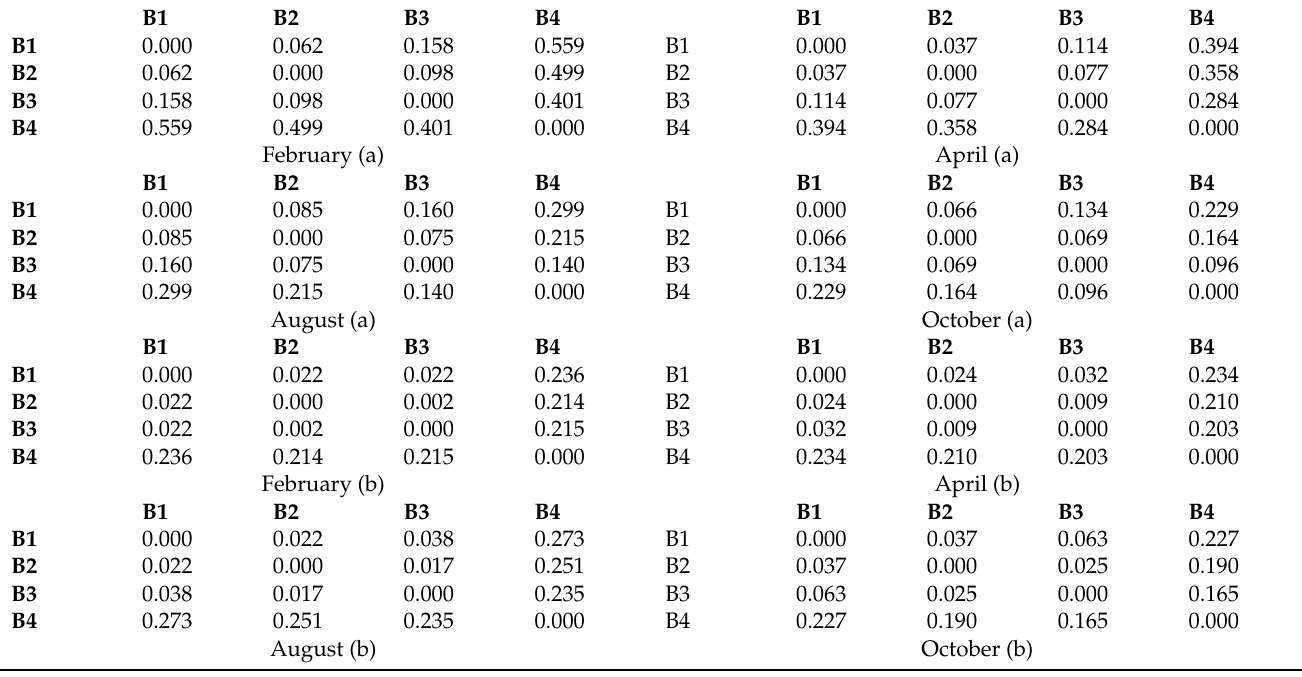
Table 4. Euclidean distance using PlanetScope; (a): Tunisian study areas, (b): Greek study